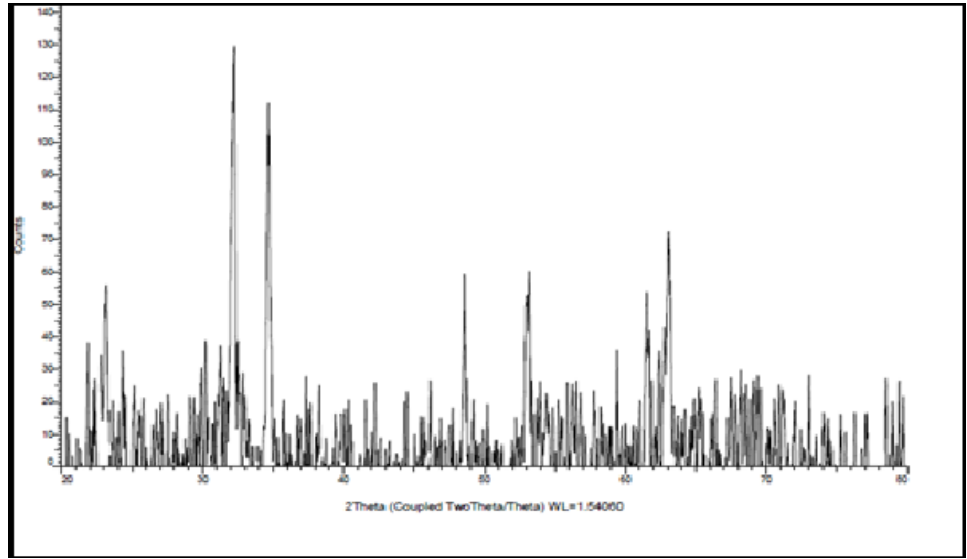
Fig.5. XRD pattern of Magnetic nano